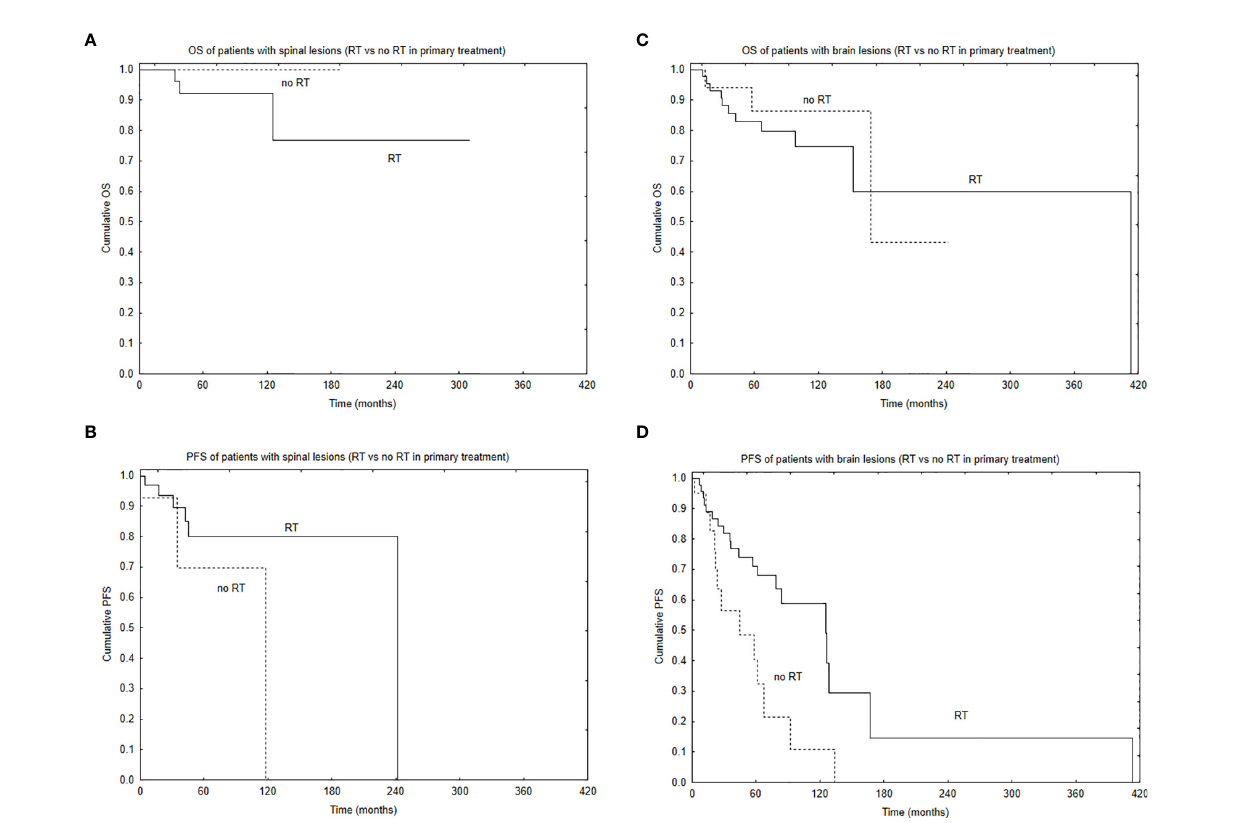
FIGURE 2 | Survival curves based on the use of radiotherapy (RT) in primary treatment with the regard to tumor location: overall survival (A) and progression-free survival (B) of patients with spinal location of the tumor based on the use of RT in primary treatment and overall survival (C) and progression-free survival (D) of patients with brain location of the tumor based on the use of RT in primary